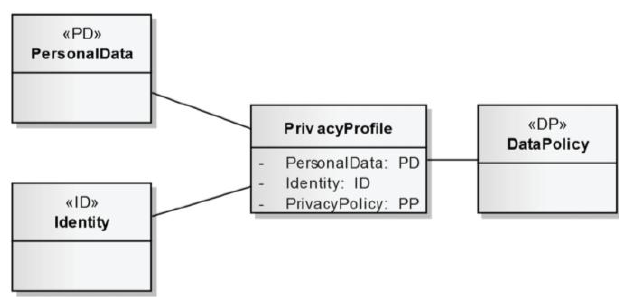
Figure 4. Privacy profile model.